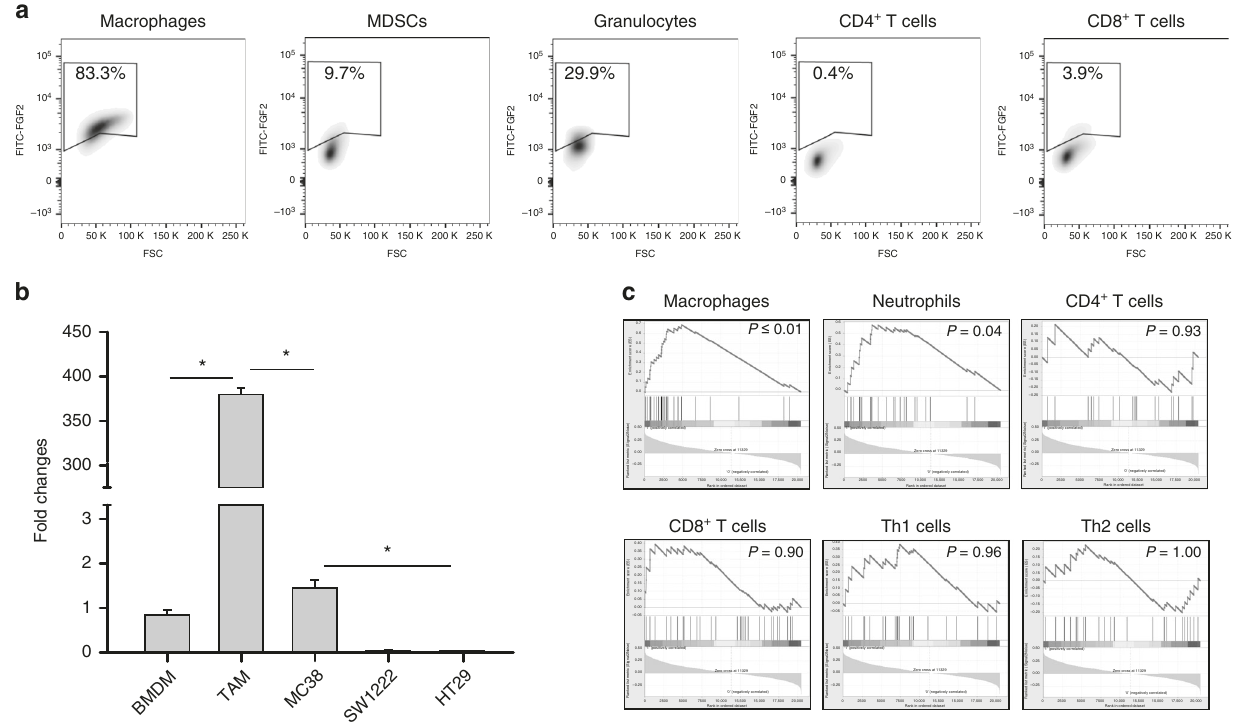
Fig. 3 Tumour-associated macrophages express FGF2. a Analysis of FGF2 expression in immune cells isolated from MC38 tumours of WT mice using fl ow cytometry; Macrophages, MDSCs, Granulocytes, CD4 + T cells and CD8 + T cells. b Shows the fold change in Fgf2 RNA expression in TAMs isolated from MC38 tumours and from the cell lines MC38, SW1222 and HT29 using BMDM as the baseline ( c ) GSEA correlation analysis of immune cell in fi ltrate and FGF2 expression in colorectal cancer patients; Macrophages, Neutrophils, CD4 + T cells, CD8 + T cells, Th1 cells and Th2 cells. * represents statistical signi fi cance compared with control mice ( p ≤ 0.05). Error bars indicate